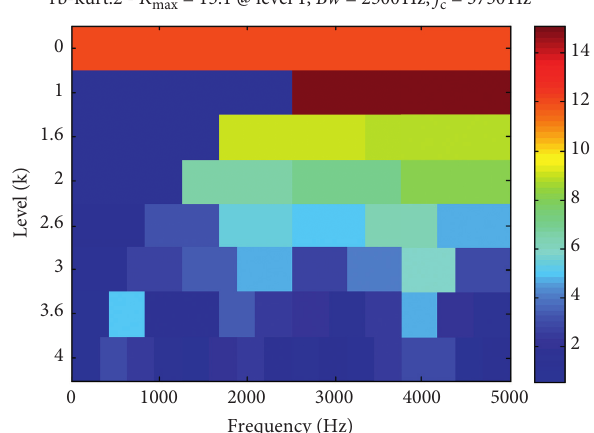
Figure 15: Fast kurtogram of low resonance component of inner race fault.